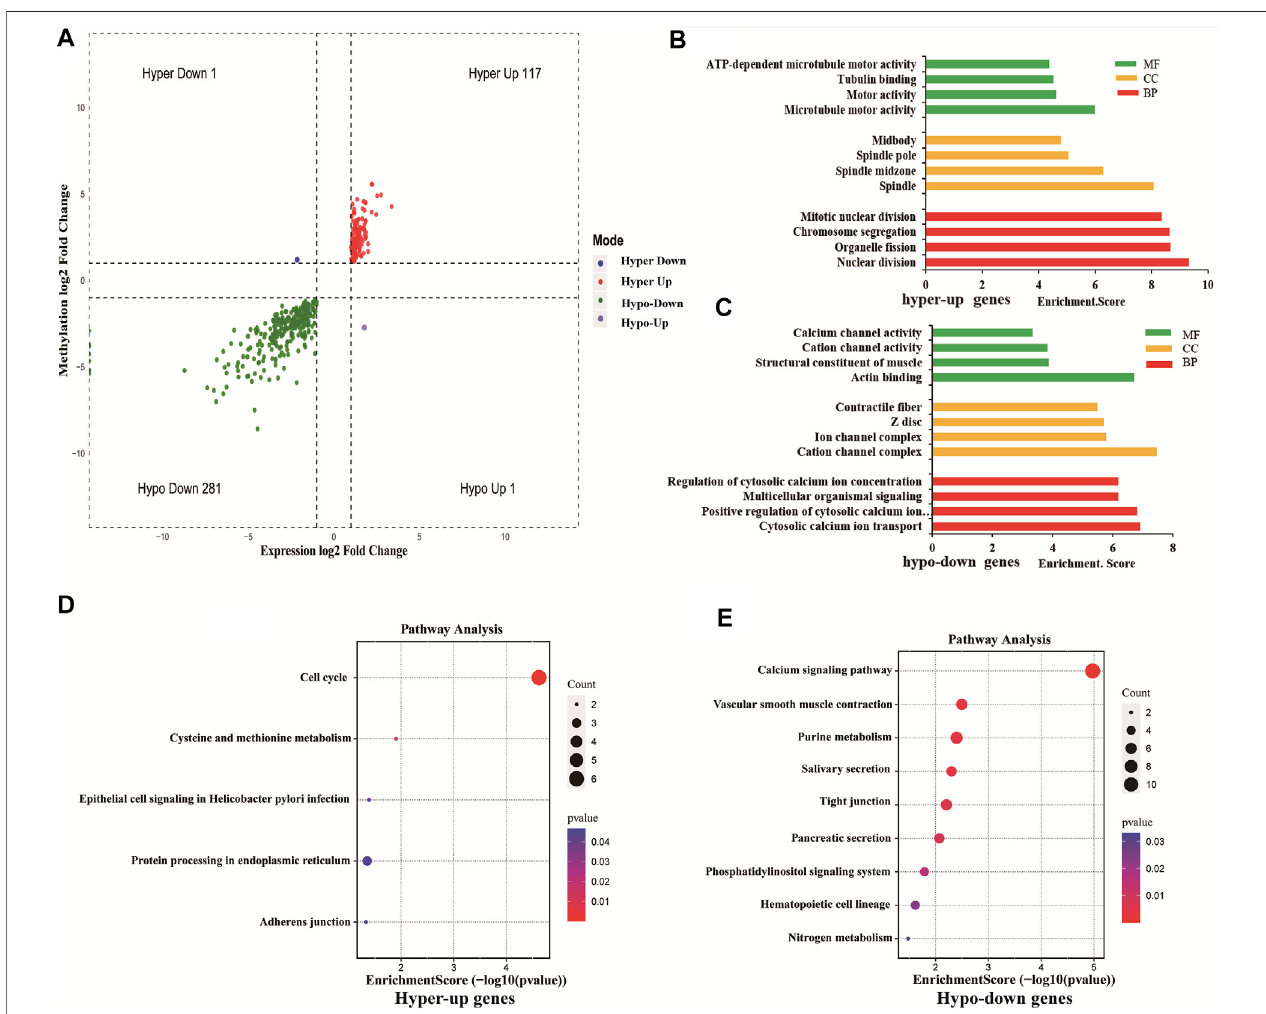
FIGURE 4 | Differentially methylated and differentially expressed mRNAs were related to cancer. (A) Four-quadrant graph showing positive correlations between differential m 6 A methylation (fold-change ≥ 2 and p -value < 0.05) and differential expression (fold-change ≥ 2 and p -value < 0.05). (B) The top 10 GO terms signi fi cantly enriched for hyper-up genes. (C) The top 10 GO terms signi fi cantly enriched for hypo-down genes. (D) The top 10 KEGG pathways signi fi cantly enriched for hyper-up genes. (E) The top 10 KEGG pathways signi fi cantly enriched for hypo-down genes.